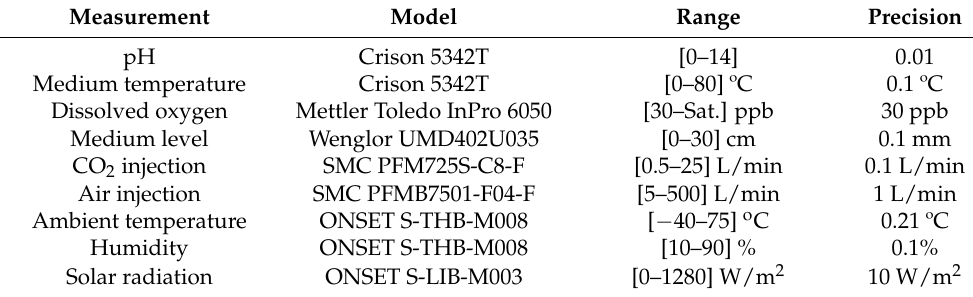
Table 1. Sensors integrated in the